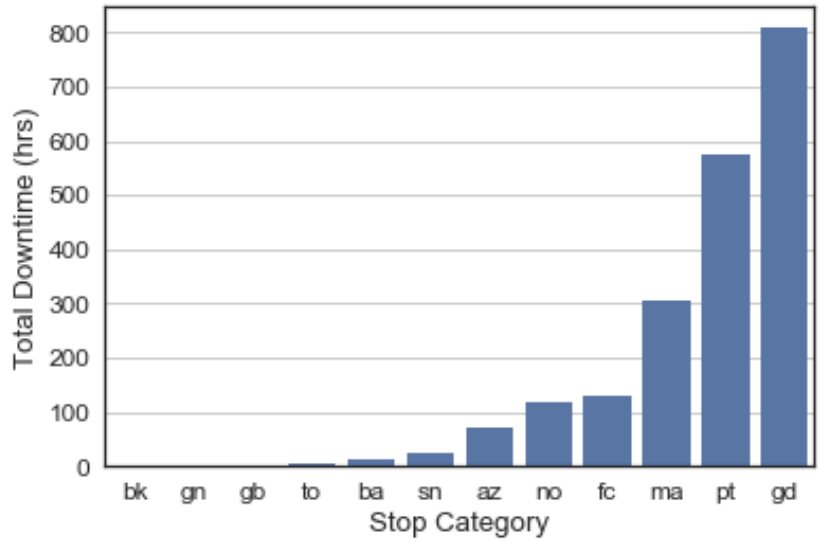
Figure 3. Total duration of stoppages for each category of stop.